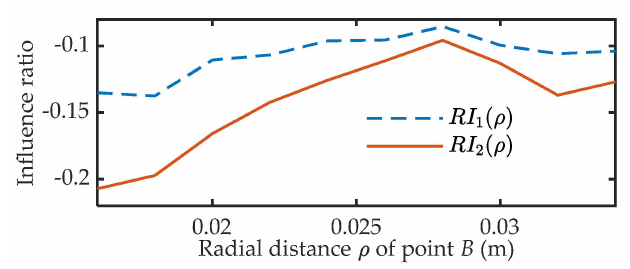
Figure 25. Influence of friction fluctuation in configuration